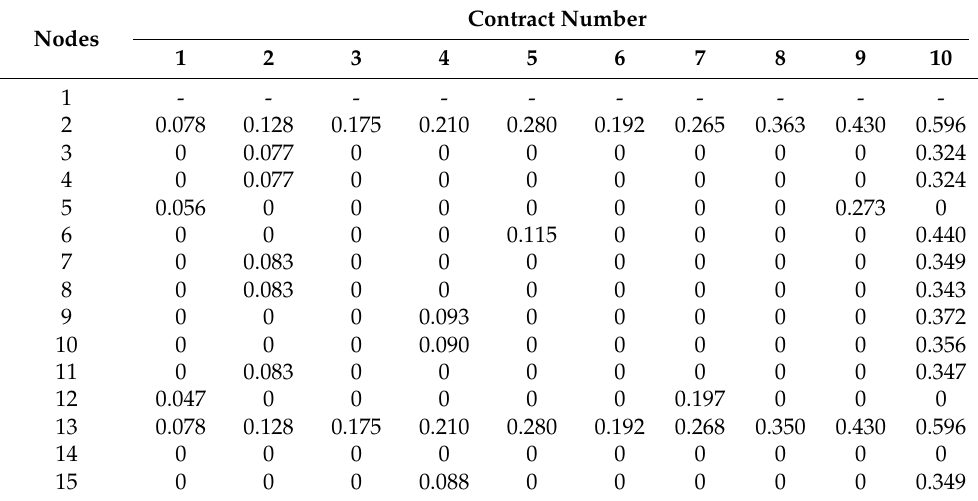
Table 4. The bilateral contract transaction value of each node under the uncertainty of spot price. Nodes